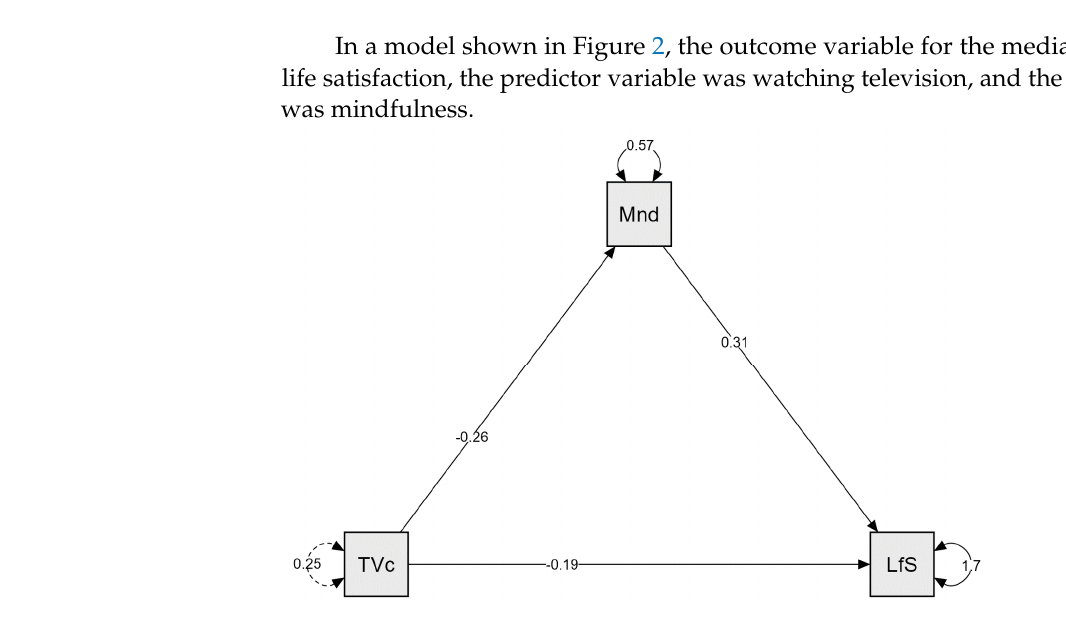
Figure 2. Mediation analysis: path plot in the total sample, the role of mindfulness as a mediator.